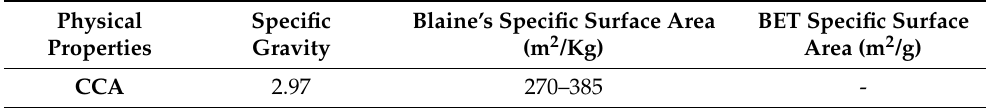
Table 9. Physical properties of CCA [18,88].